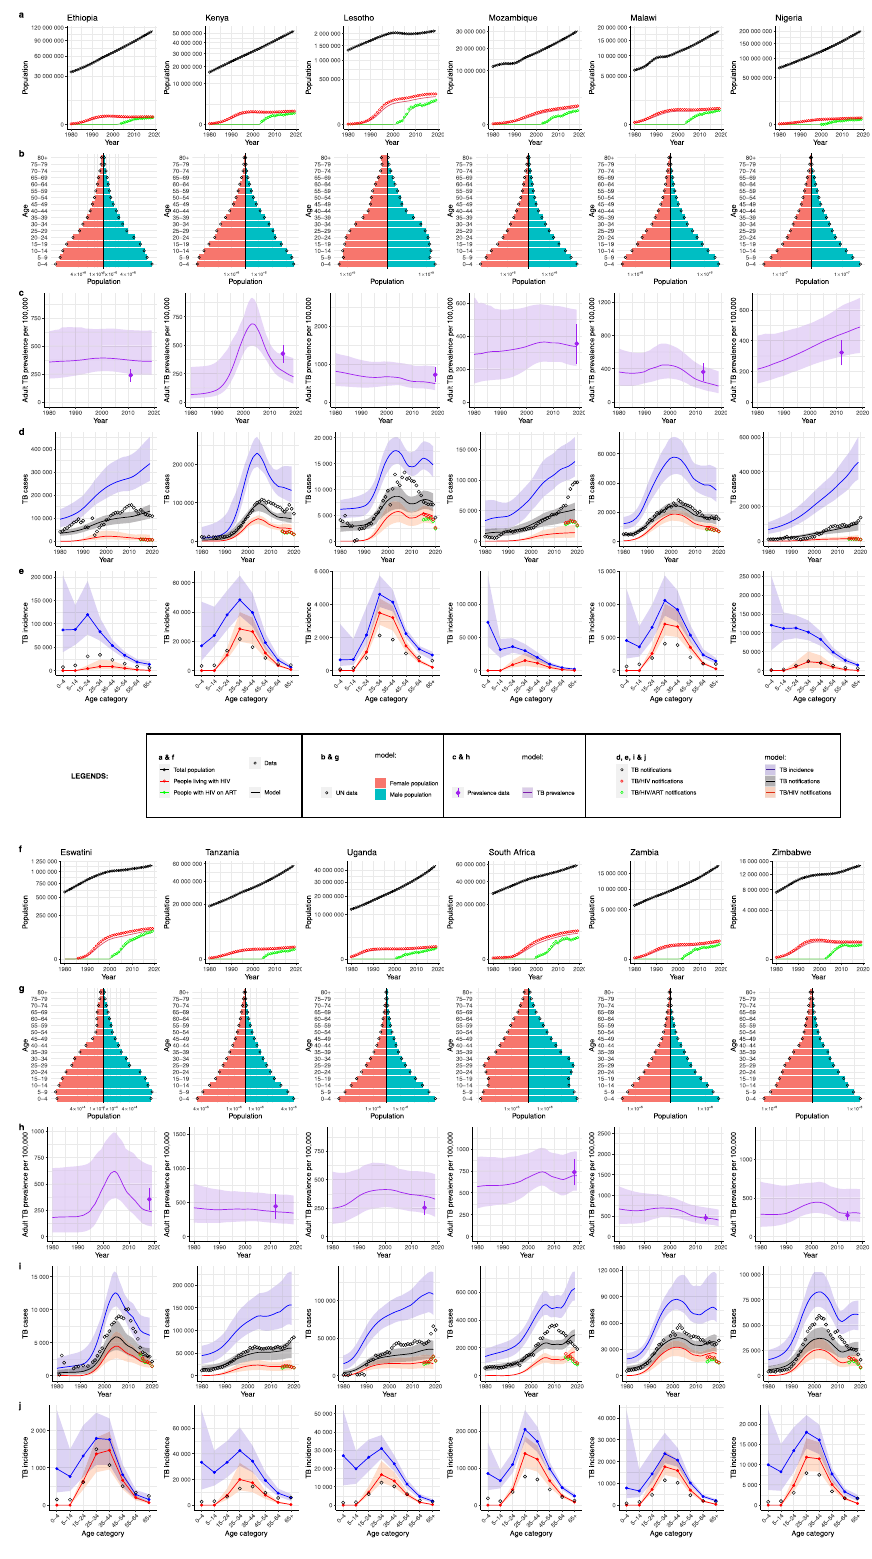
Fig. 2 | Model outputs compared to empirical data for 12 African countries. Rows a , f total population (black), people living with HIV (red), people on ART (green)1980 – 2019-points=data,lines=model.Rows b , g :demographicsnapshotin 2015 red/left=women, blue/right=men, points=data. Rows c , h : per capita TB pre- valence 1980 – 2019, (line=median, ribbon=95% credible interval [CrI]), and TB prevalence survey data (point=central estimate; error bar=95% con fi dence inter- val). Rows d , i : incident TB 1980 – 2019, lines=median/ribbon=95%CrI for model,